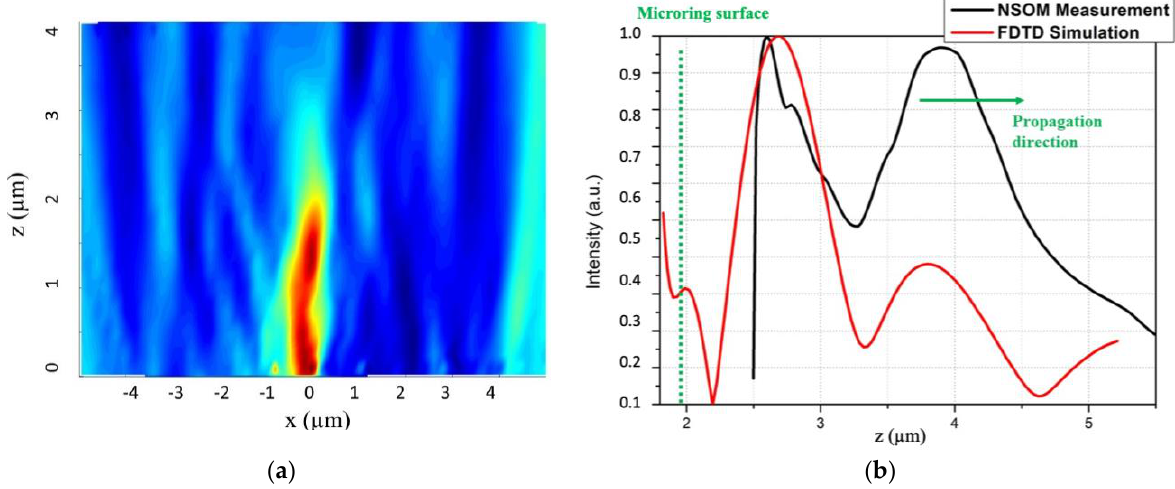
Figure 7. ( a ) Measured near field of the MRZ structure illuminated by 420 nm LED diode along the propagation direction, ( b ) comparison of simulated electric field intensity profile and measured near field along the propagation direction at x = 0.